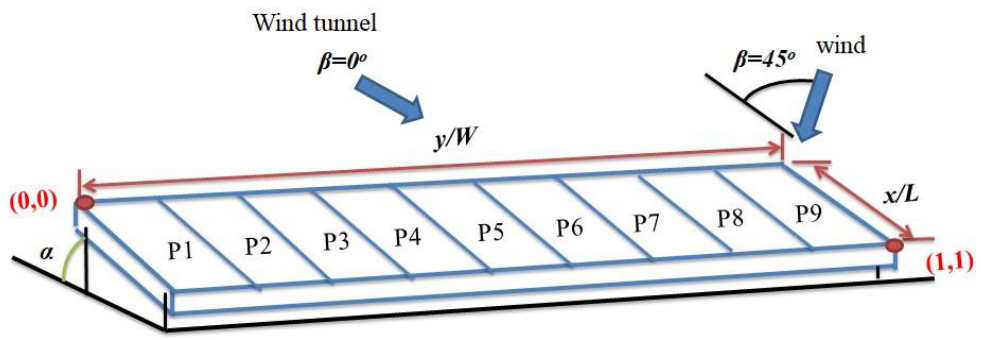
Figure 1. Test configuration for a stand-alone array.